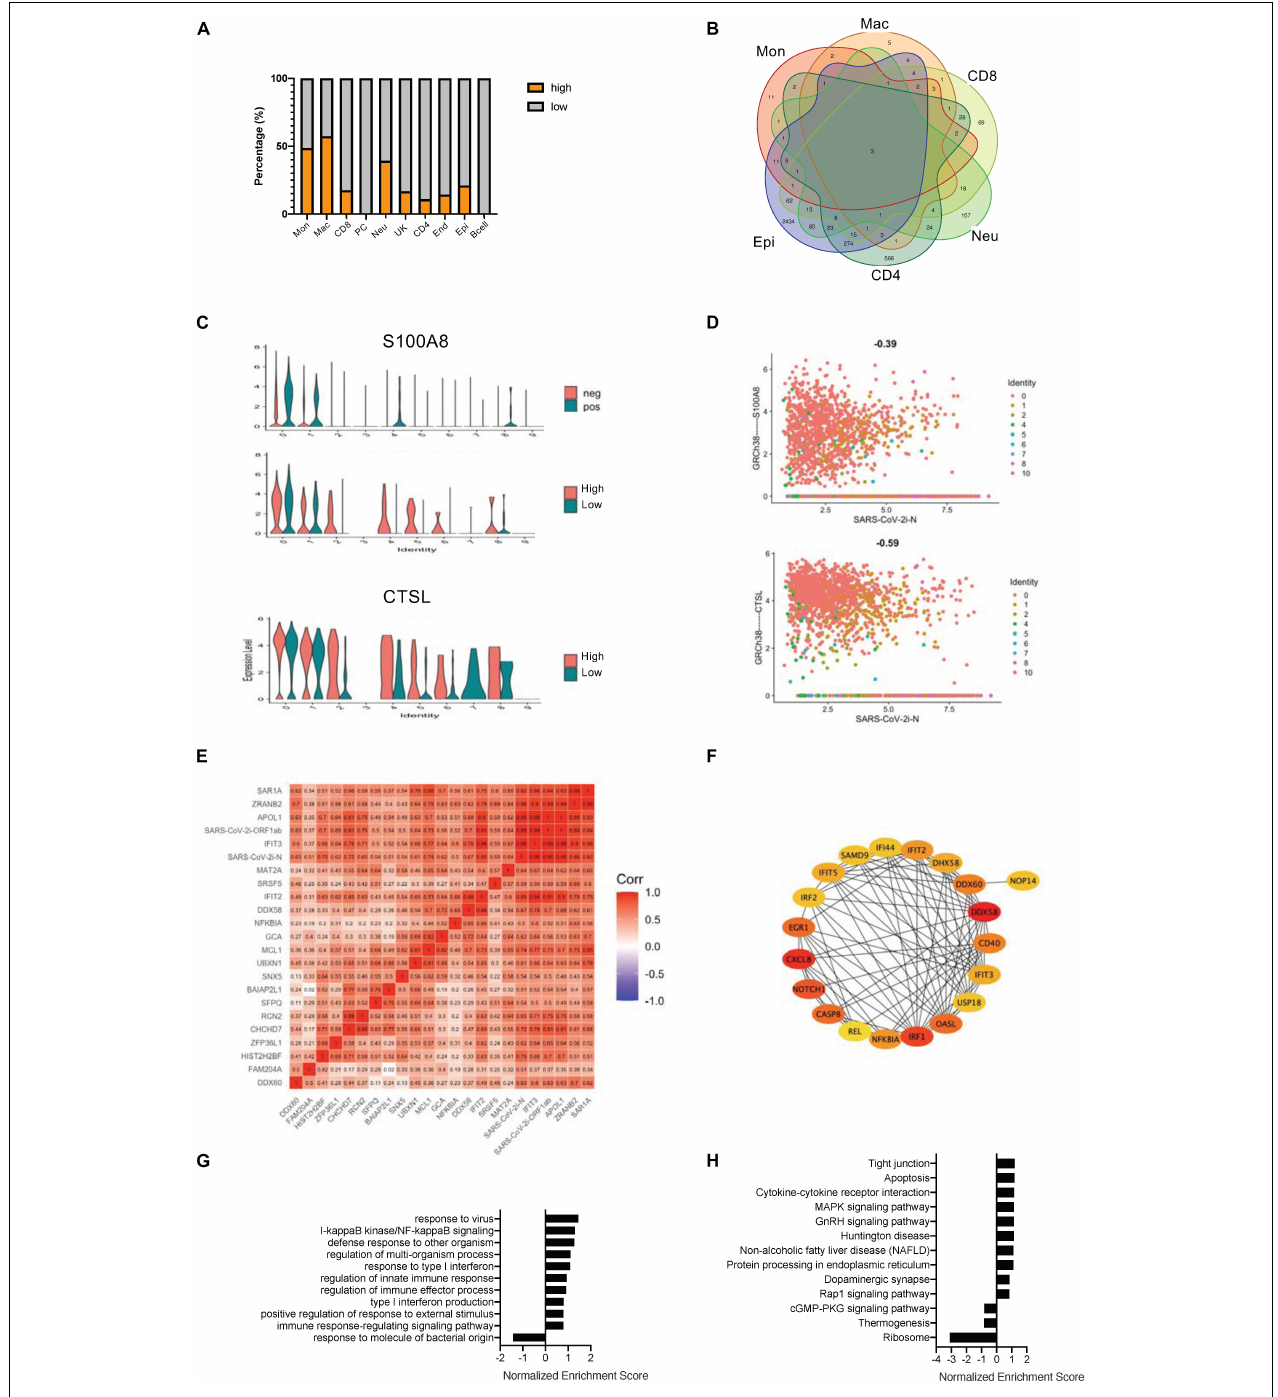
FIGURE 2 | Correlation of SARS-CoV-2 infection with the COVID-19–related gene signatures. (A) Bar charts to quantify the proportion of heavily loaded SARS-CoV-2 in the main cell types. (B) A Venn diagram highlighting the intersecting gene signatures of heavily loaded SARS-CoV-2 cells. (C) Violin plots indicating the levels of S100A8 expression in SARS-CoV-2 positive and negative cells. Violin plots indicating the expression levels of S100A8 and CTSL in heavily loaded SARS-CoV-2 cells. (D) Feature plots revealing the relationship between COVID-19–related genes and either S100A8 or CTSL gene expression in heavily loaded SARS-CoV-2 cells. (E) A heat map revealing the relationship between COVID-19–related genes and DEGs in the SARS-CoV-2-infected epithelial cells. (F) The PPI network demonstrating the COVID-19–related infection-correlated hub gene signatures in the SARS-CoV-2-infected epithelial cells. (G) The enriched gene ontology of GSEA analysis for SARS-CoV-2-infected epithelial cell-correlated gene signatures. (H) The enriched KEGG signaling pathway of GSEA analyses for SARS-CoV-2-infected epithelial cell-correlated gene signatures.